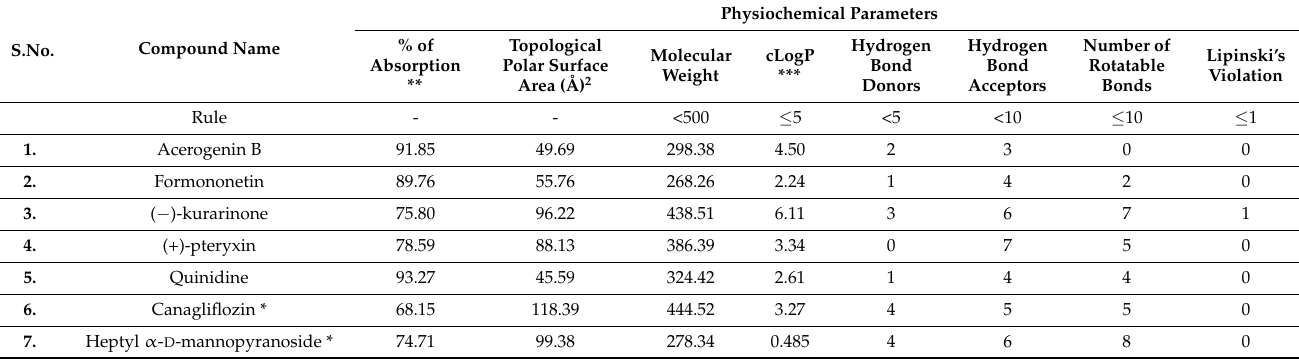
Table 1. Physicochemical properties of natural sodium–glucose co-transporter 2 (SGLT2) inhibitors and control compounds.